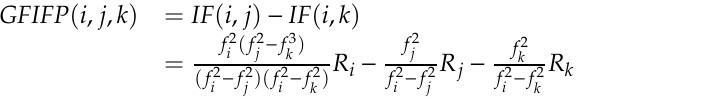
Table 5. The results of the overlap comparison of the BD3 two-day overlap in the along-track, cross- track, radial and 3D directions (units: mm). The mean observation counts used in each arc are listed in the last column.